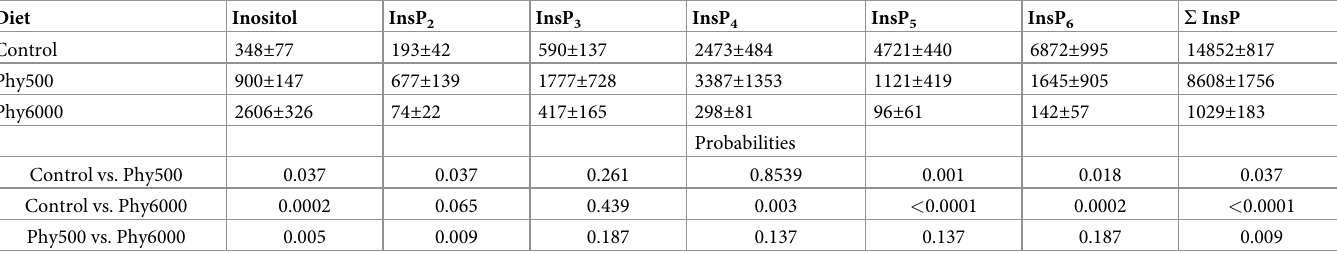
Table 3. Inositol and inositol phosphate (InsP 2-6 ) levels (nmol/g dwt) in gizzard digesta of day 21 broilers 1,2